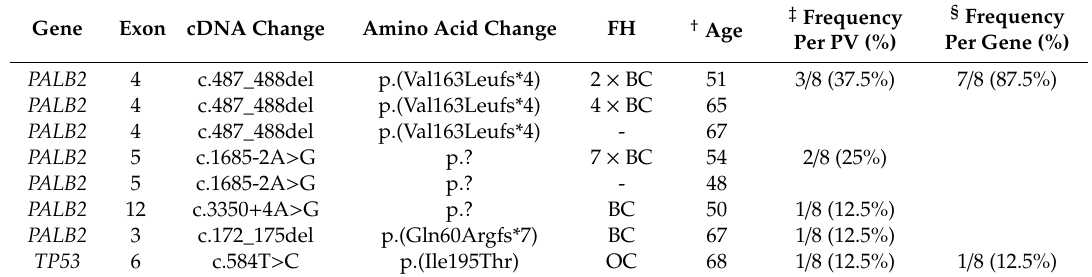
FH: Family history of cancer, with first- or second-degree relatives diagnosed with breast, ovarian, pancreatic, or colorectal cancer. † Age at diagnosis with Triple-Negative Breast Cancer (years). ‡ Patients carrying the pathogenic variant (PV) / patients tested positive for PVs in established breast cancer (BC) susceptibility genes. § Patients carrying PVs per gene / patients tested positive for PVs in established BC susceptibility genes.